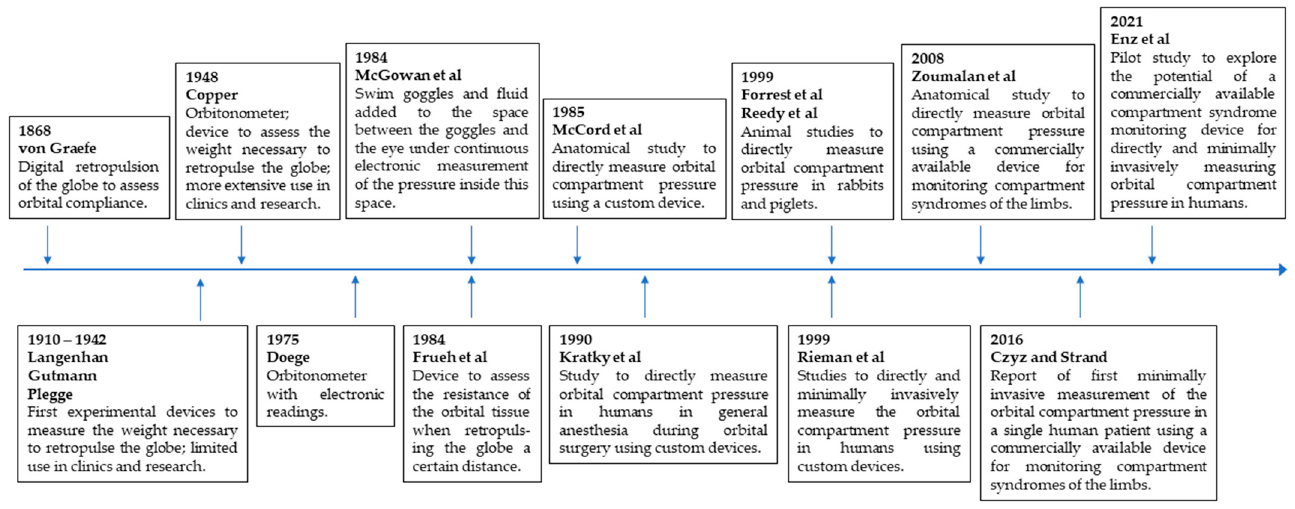
Figure 2. Timeline of the development of the different methods to measure orbital compartment pressure.